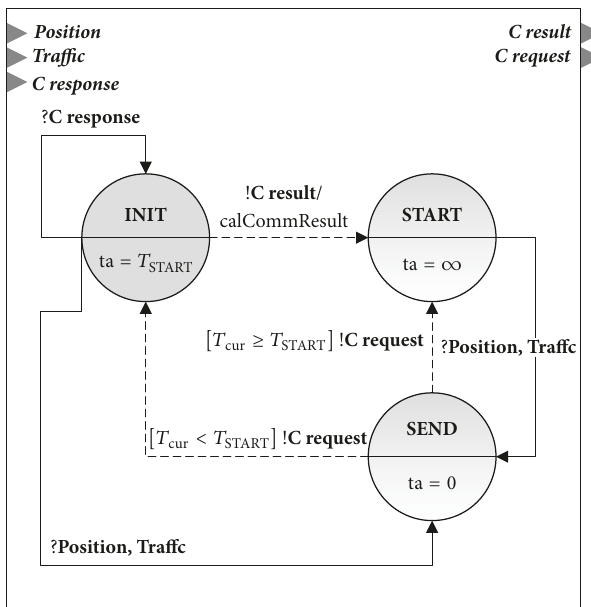
Figure 9: Interface model design using the DEVS formalism.